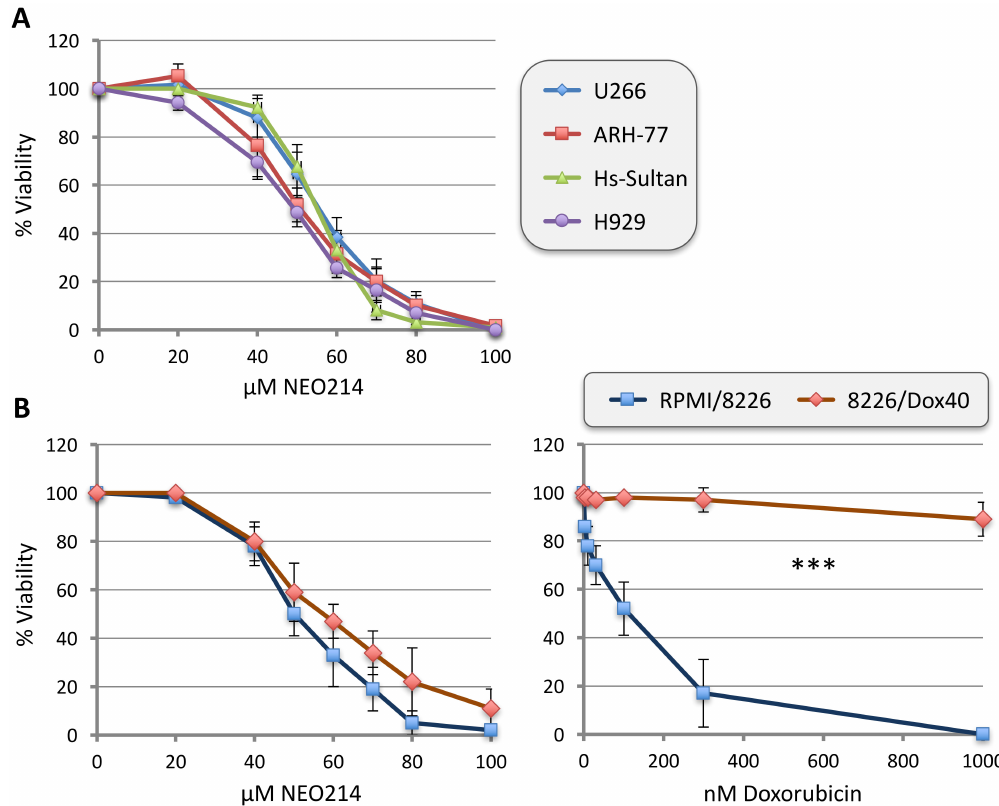
Figure 2. NEO214 kills multiple myeloma (MM) cells in vitro. Different MM cell lines were treated at increasing concentrations of NEO214, and cell viability was determined 48 h later by standard Methylthiazoletetrazolium (MTT) assay. ( A ) U266, ARH-77, H929, and Hs-Sultan cells were used. ( B ) RPMI/8222 and 8226/Dox40 cells were used. The right panel demonstrates very large differential in response to doxorubicin treatment, confirming high drug-resistance status of the Dox40 subline. Asterisks (***): statistical difference between data points ≥ 25 nM doxorubicin: p < 0.001). In all cases, vehicle-only treated cells, as well as entirely untreated cells, were used as controls (there was no difference between the two). Survival of untreated cells was set at 100%. Data points are mean ± SE from ≥ 3 independent experiments.